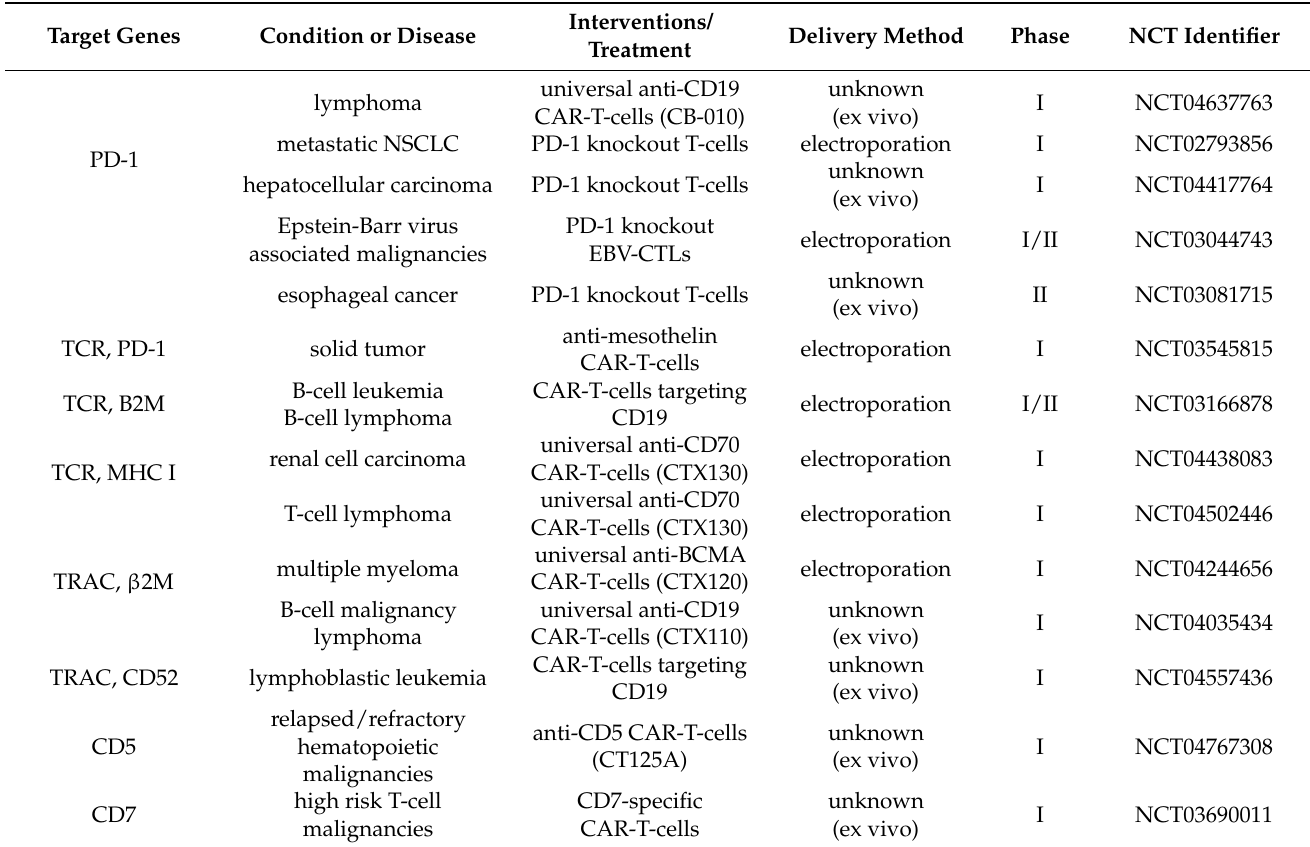
Table 1. CRISPR/Cas9-based clinical trials collected from the ClinicalTrial.gov website (accessed on 20 September 2021). Target